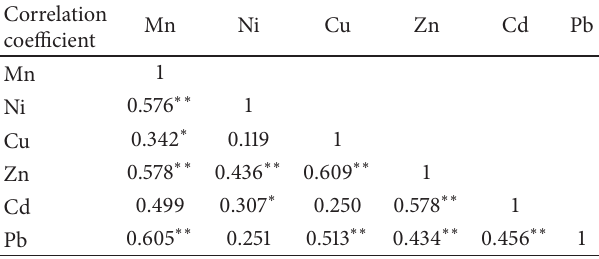
Table 2: Correlation test of the